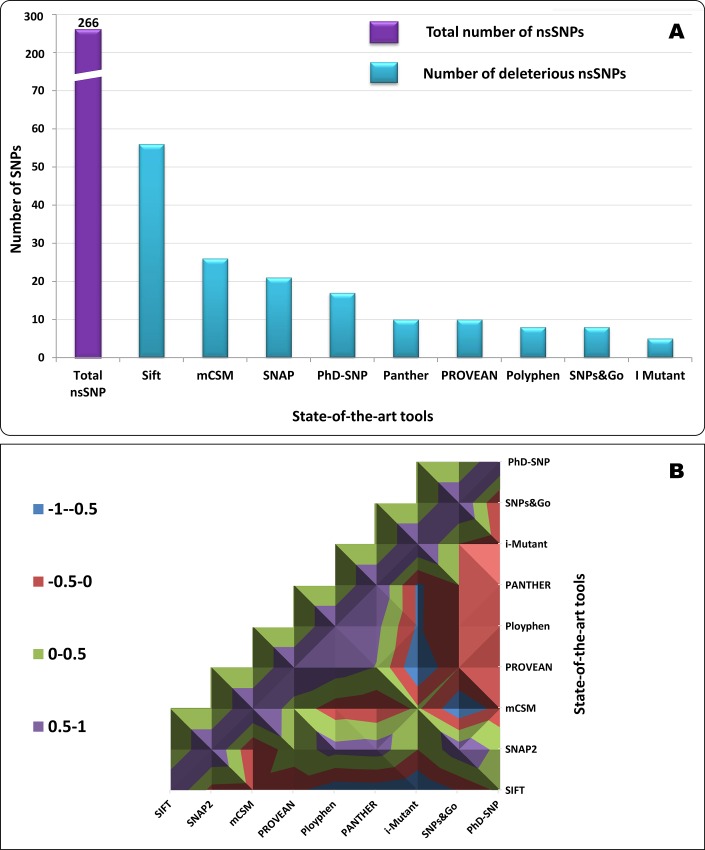
Screening for, and prediction of, deleterious nsSNPs in the BCL11A gene by different computational tools.A: Number of nsSNPs predicted as pathogenic by each state-of-the-art tool. B: Surface chart of the correlations among predictions of deleterious nsSNPs in the BCL11A gene by different computational tools.